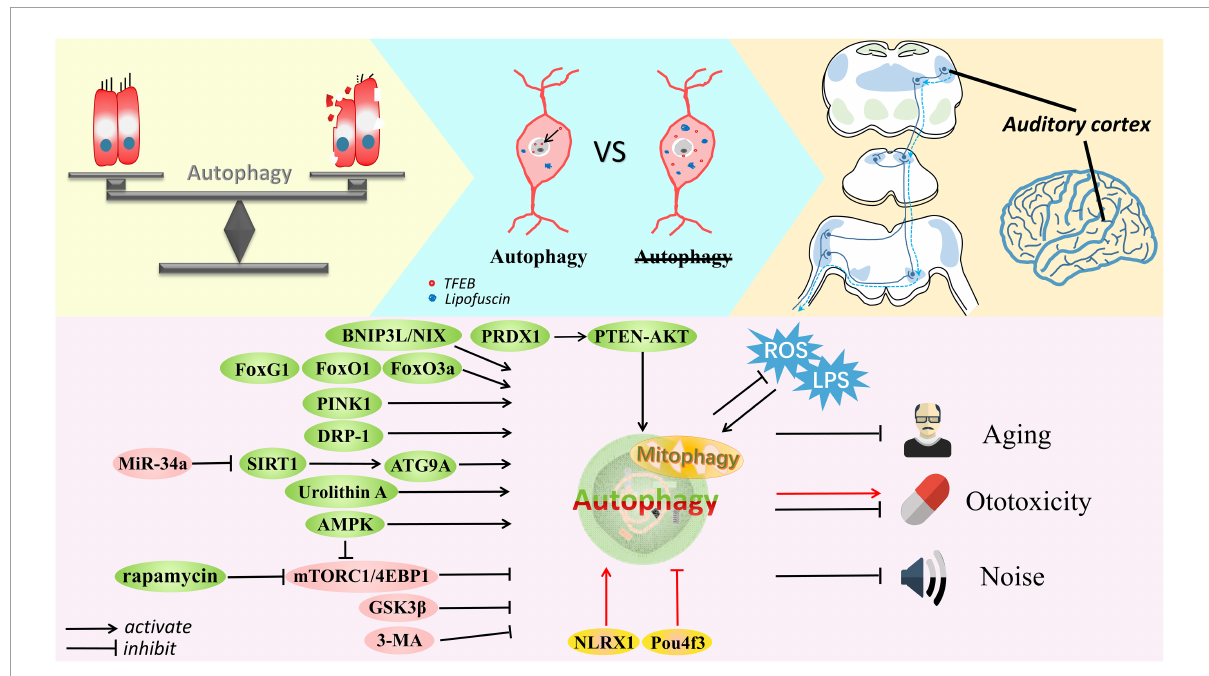
FIGURE2 The delicate balance of autophagy in cell survival and death. Autophagy is involved in the auditory pathway, which is reviewed exactly from the peripheral to the central auditory system. Autophagy is activated by Fox family members, BNIP3L, Urolithin A, PINK1, AMPK, DRP-1, rapamycin, SIRT1, and PRDX1 but inhibited by miR-34a, 3-MA, GSK3 β , and mTORC1 signaling in cells suffering from aging, noise and ototoxic drugs. Some common stresses usually exist, such as ROS and LPS. Accumulated lipofuscin and disrupted nuclear translocation of TFEB are shown in degenerated SGNs with impaired autophagy; in contrast, SGN degeneration is ameliorated after restoring autophagy and promoting TFEB nuclear translocation. Furthermore, autophagy is thought to defend against damage to the auditory cortex caused by aging or ototoxicity. Autophagy can alleviate these conditions and protect cells, although controversy remains. Activation of autophagy by Pou4f3 mutation and NLRX1 mediation can accelerate the ototoxic potential of cisplatin in hair cells and HEI-OC1 cells. Most importantly, appropriate autophagy plays a vital role in maintaining the balance of cell